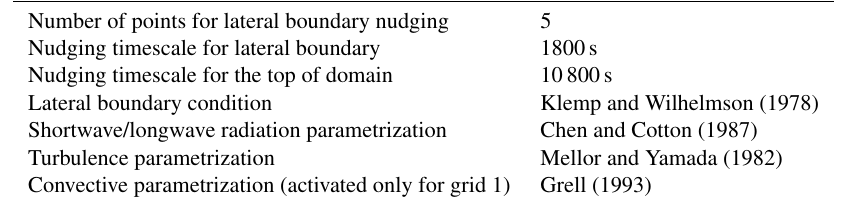
Table 1. BRAMS main configuration.